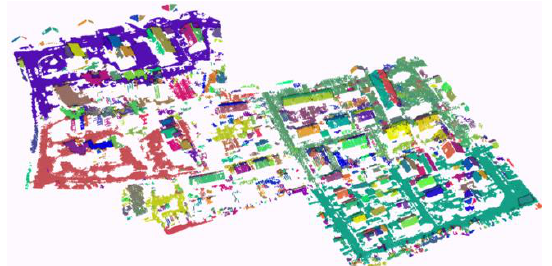
Figure 10. Result of region growing segmentation on Vaihingen’s training data. Each segment is shown with a randomly assigned colour.